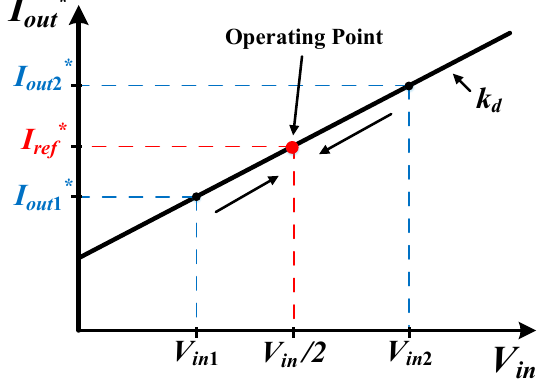
Figure 3. Decentralized control characteristics.